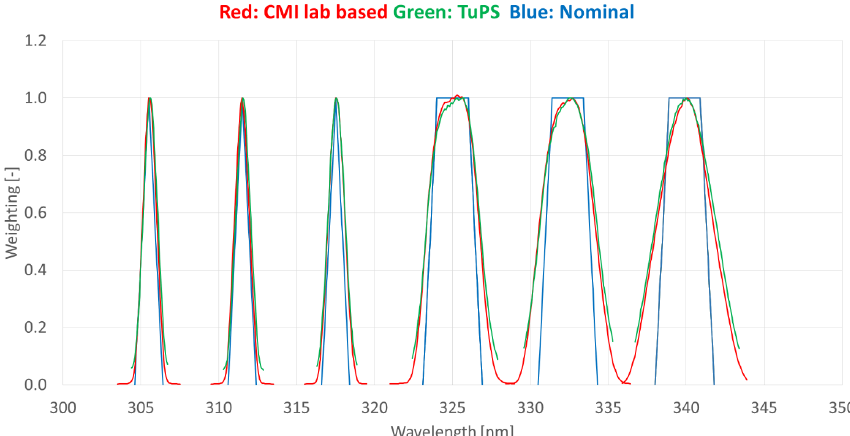
Figure 10. Comparison of in-field calibration and CMI laboratory-based calibration of Dobson #074.